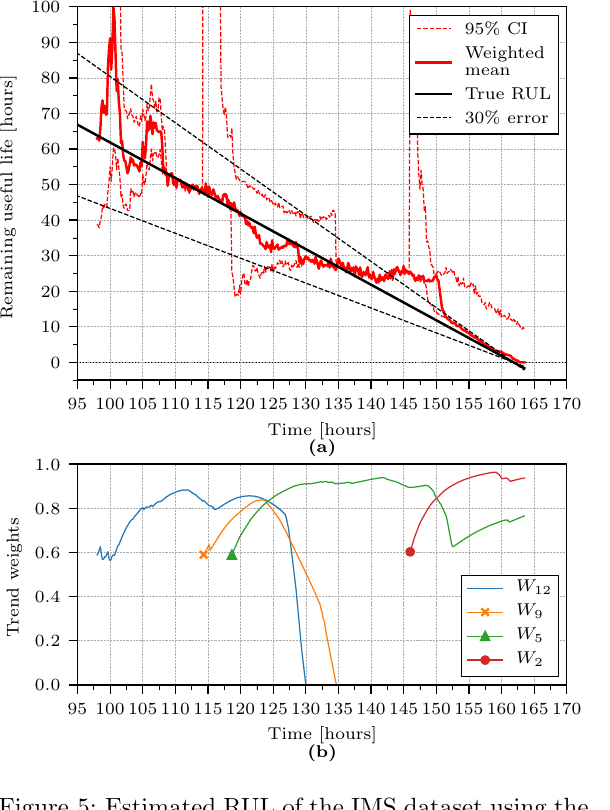
Figure 5: Estimated RUL of the IMS dataset using the proposed method. (a) weighted mean, 95% CI, true RUL and 30% error margins; (b) weights for each PF prediction.